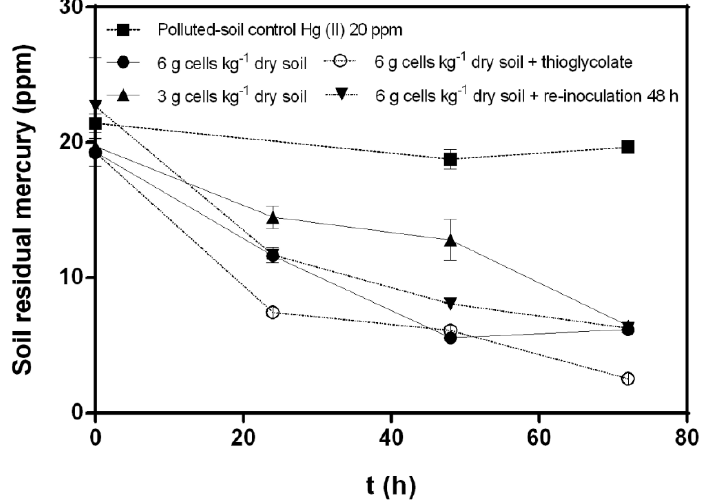
Figure 2. Effects of cellular concentration, thioglycolate, and cellular re-inoculation on mercury (II) (20 ppm) bioremediation by C. metallidurans MSR33 on mercury-polluted agricultural soil in a rotary drum bioreactor. ( ■ ) Hg-polluted soil control, ( ● ) Hg-polluted soil bioremediation with MSR33 cells concentration of 6 g cells kg − 1 dry soil, ( ▲ ) Hg-polluted soil bioremediation with MSR33 cells concentration of 3 g cells kg − 1 dry soil, ( ○ ) Hg-polluted soil bioremediation with MSR33 cells concentration of 6 g cells kg − 1 dry soil plus thioglycolate (5 mM), ( ▼ ) Hg-polluted soil bioremediation with MSR33 cells concentration of 6 g cells kg − 1 dry soil plus cells re-inoculation at 48 h. The assays were performed in duplicate; bars indicate the standard deviation.